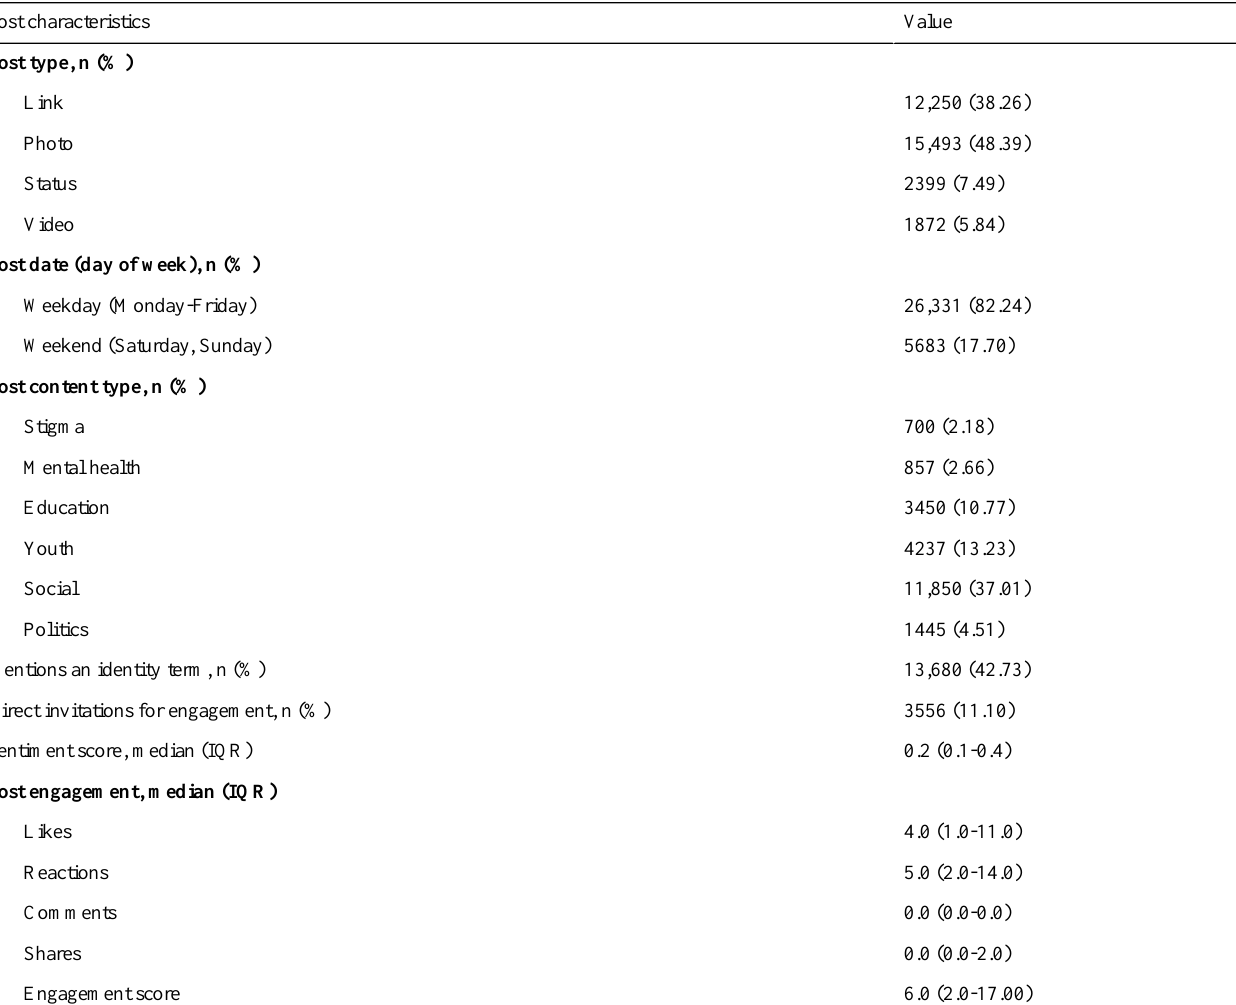
Table 1. Characteristics of Facebook posts by lesbian, gay, bisexual, transgender, and queer community centers, 2017